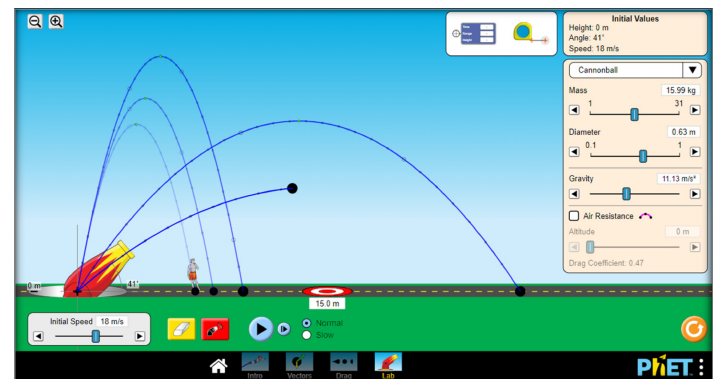
Figure 1. Simulation-based activity for learning projectile